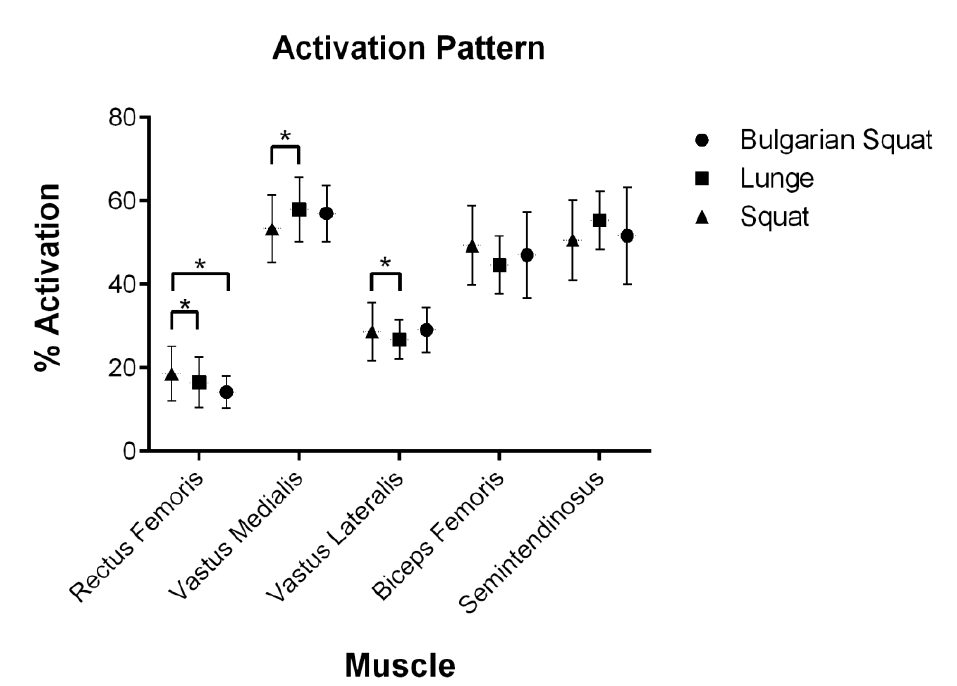
Figure 4. Intra-muscular group activation pattern (mean ± standard deviation) in percentage. The intragroup muscular ratio expresses the activation of each muscle with respect to the total surface muscular activity of each muscle. The brackets (*) with an asterisk show that there is a significant di ff erence between these two exercises. The vertical lines around the data represent the standard deviation (SD).